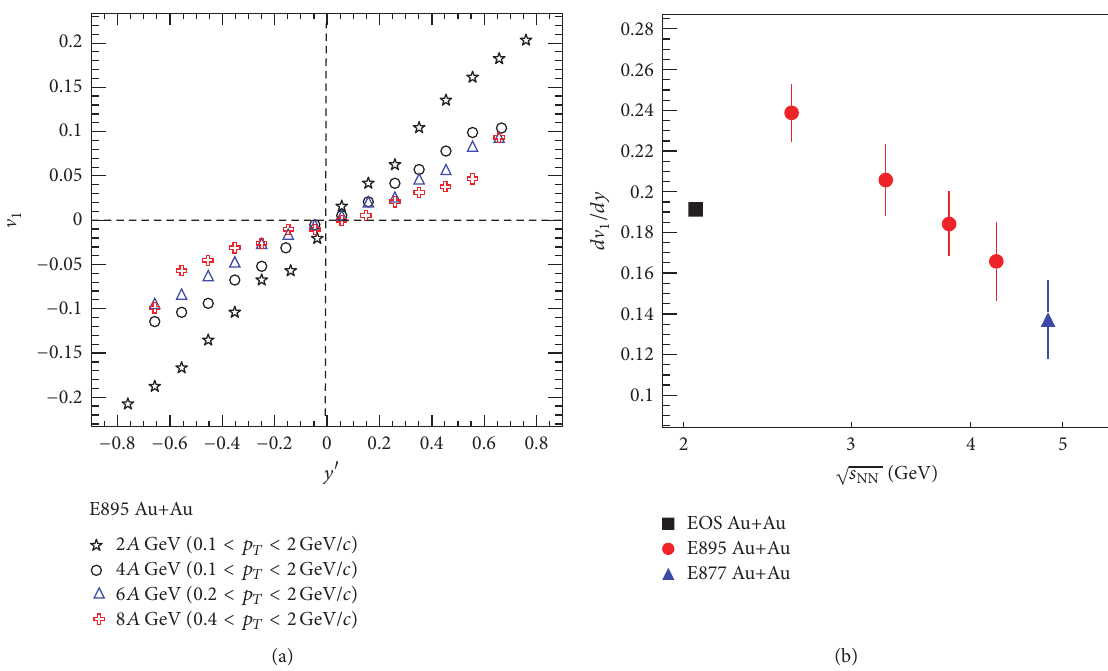
Figure 9: (a) V 1 (𝑦 󸀠 ) for protons in 2 𝐴 , 4 𝐴 , 6 𝐴 , and 8 𝐴 GeV Au+Au collisions measured by E895 [34]. (b) Beam energy dependence of the slope 𝑑 V 1 /𝑑𝑦 (here using unnormalized rapidity) for protons, replotted using the more ubiquitous beam energy scale √𝑠 NN [34]. A point from the same detector at the Bevalac [71] and another from E877 at the top AGS energy [31] are also